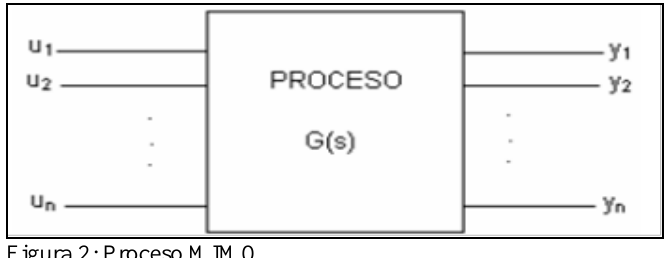
Figura 2: Proceso